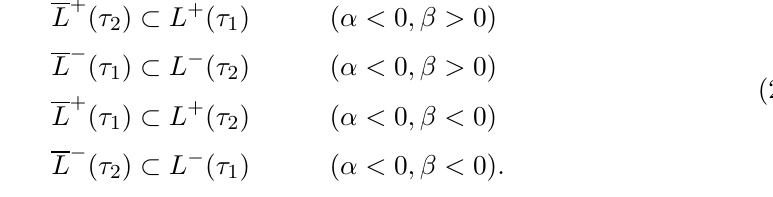
Figure 1 . Generic Penrose diagrams for spacetime regions K divided by the light sheets N k ( (cid:27) ) and N l ( (cid:27) ), respectively, de(cid:12)ned in eq.